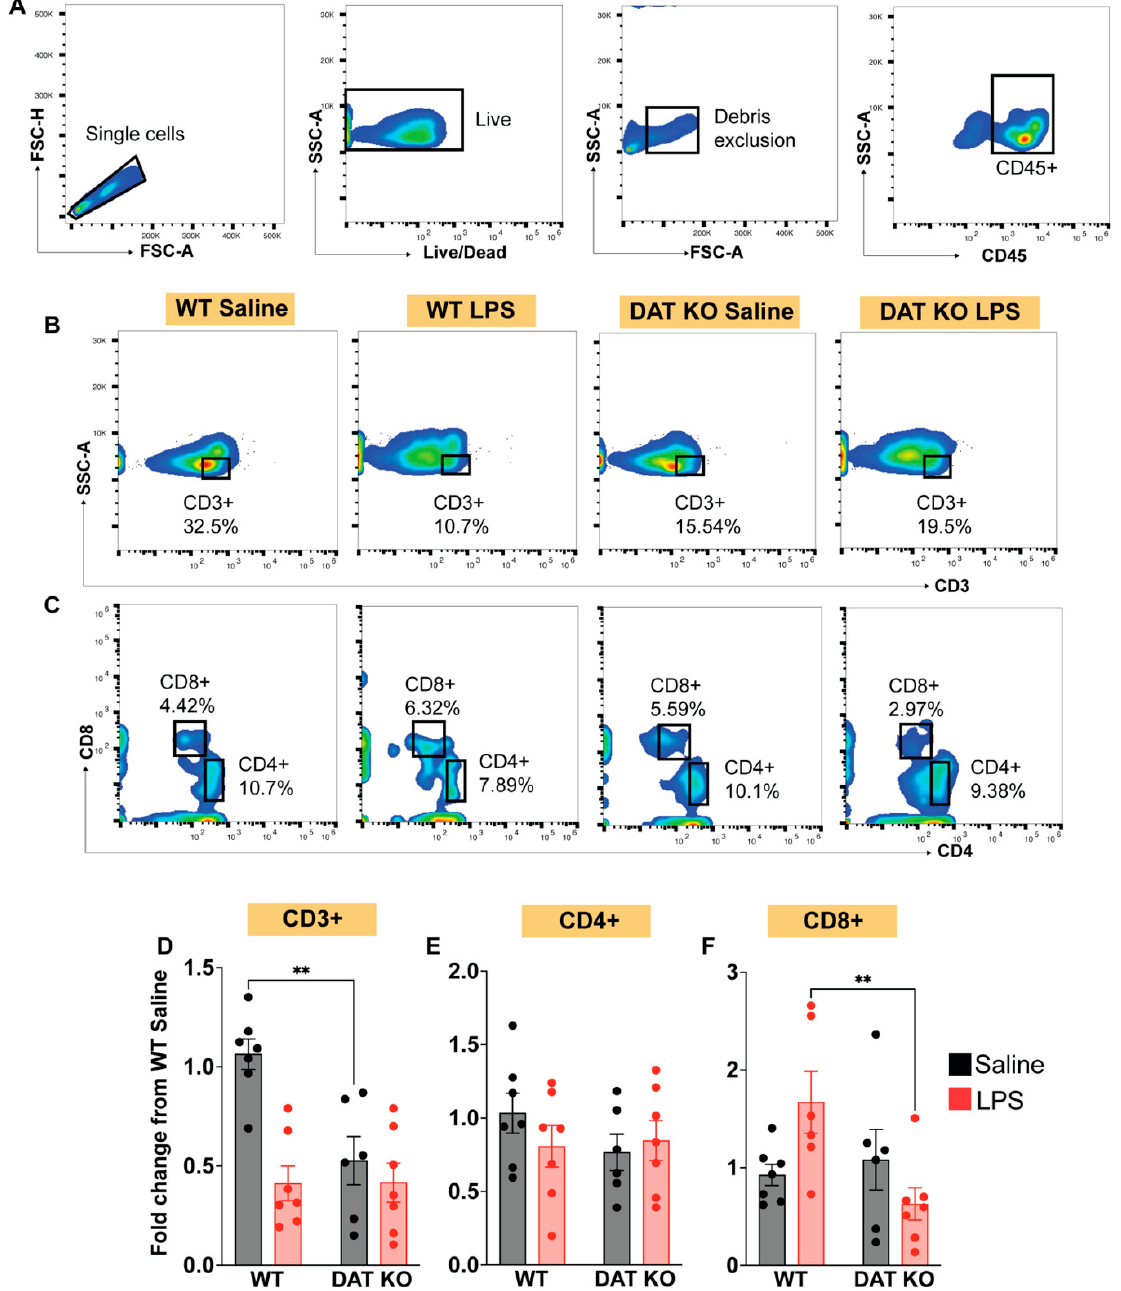
Figure 6. Mice lacking DAT exhibit suppressed T-cell populations both at baseline and following immune stimulation. ( A ) Gating relevant CD45+ leukocytes; ( B , C ) assessment of T-cell subsets (CD3+, CD4+, CD8+); ( D ) in WT mice, CD3+ T-cells are reduced following LPS immune stimulation (activation induced cell death, AICD; p < 0.05); however, DAT − / − mice show reduced CD3+ cells even at baseline, which is unchanged in response to LPS-induced immune stimulation. ( E ) Further assessments of T-cell subsets show that CD4+ T cells are not significantly altered in any treatment groups regardless of DAT expression or LPS-induced immune stimulation. ( F ) Unlike WT mice, the CD8 T-cells of DAT − / − mice contract following LPS-induced immune stimulation. These results suggest that the adaptive immune system is hobbled in the absence of DAT. (Two-way ANOVA with Sidak’s correction for multiple comparisons; n = 6–9 per group. ** p < 0.01).